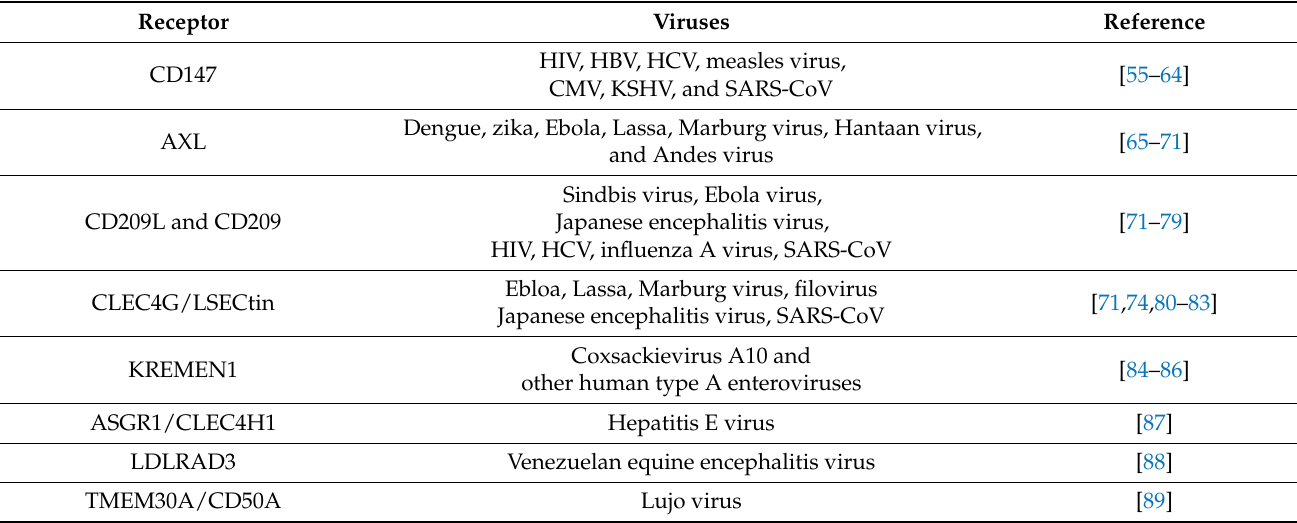
Table 2. Involvement of ACE2-indepenent alternative receptors in viruses other than SARS-CoV-2. Receptor